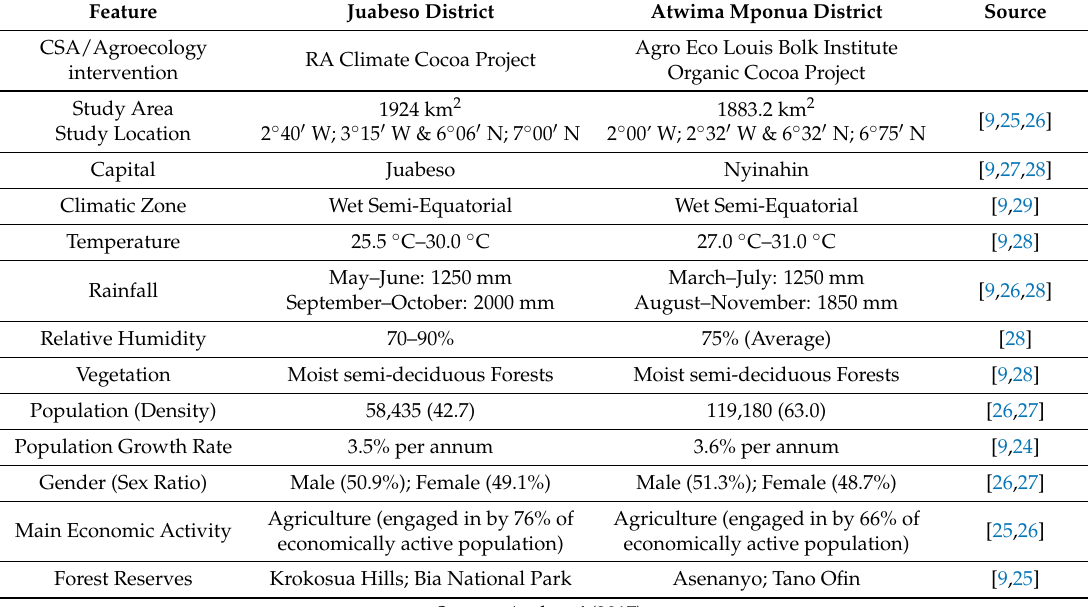
Table 1. Profile of the study area